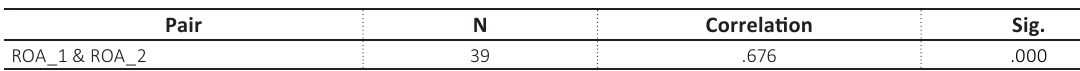
Table A5. Paired samples correlations (the result of H2a )